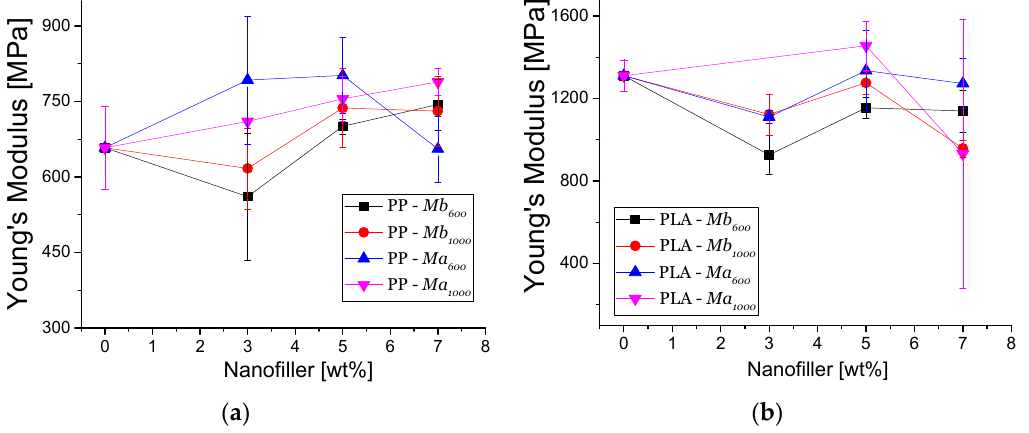
Figure 5. Young’s modulus of nanocomposites: ( a ) PP-TrGO:Fe 3 O 4 ; ( b ) PLA-TrGO:Fe 3 O 4 .